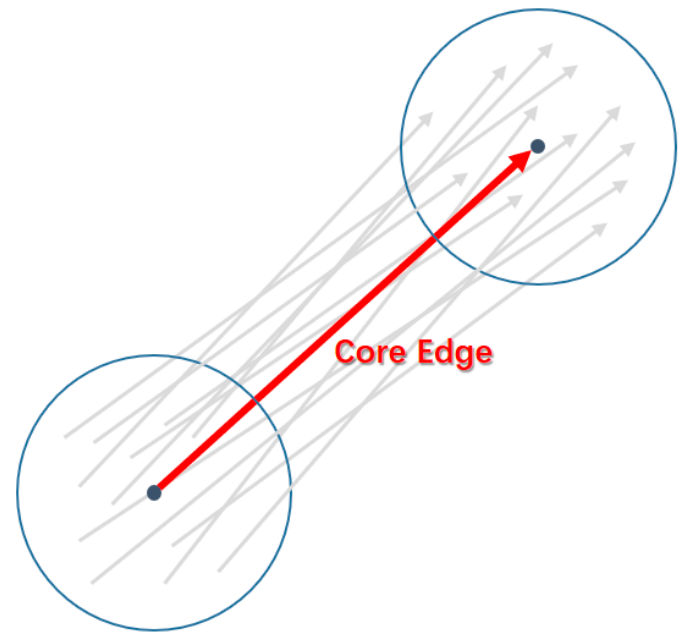
Figure 6. An edge cluster of a large flow and its core edge.